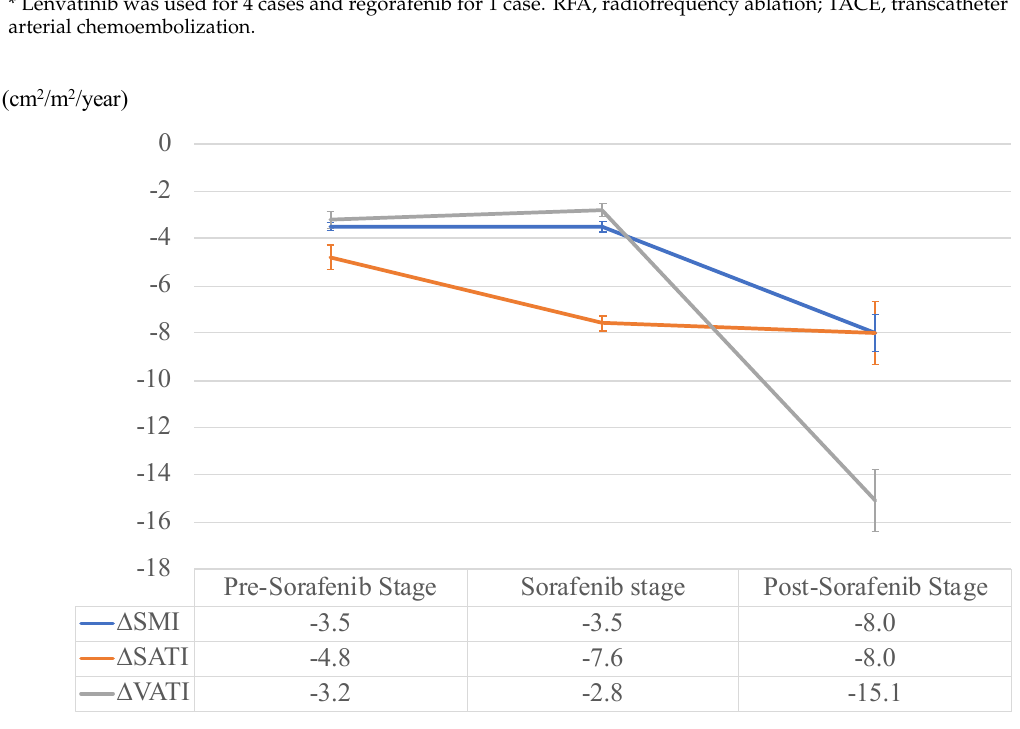
Figure 2. Annualized changes in skeletal muscle index (SMI), subcutaneous adipose tissue index (SATI), and visceral adipose tissue index (VATI) at the pre-sorafenib, duration of sorafenib treatment, and post-sorafenib stages. Error bars represent standard errors.